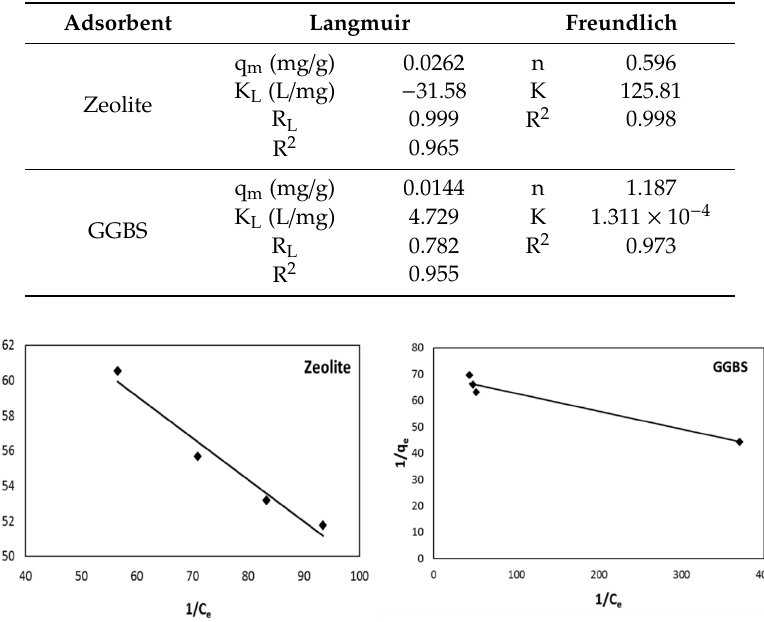
Figure 4. Langmuir model for adsorption of Cr(VI) onto zeolite and GGBS.